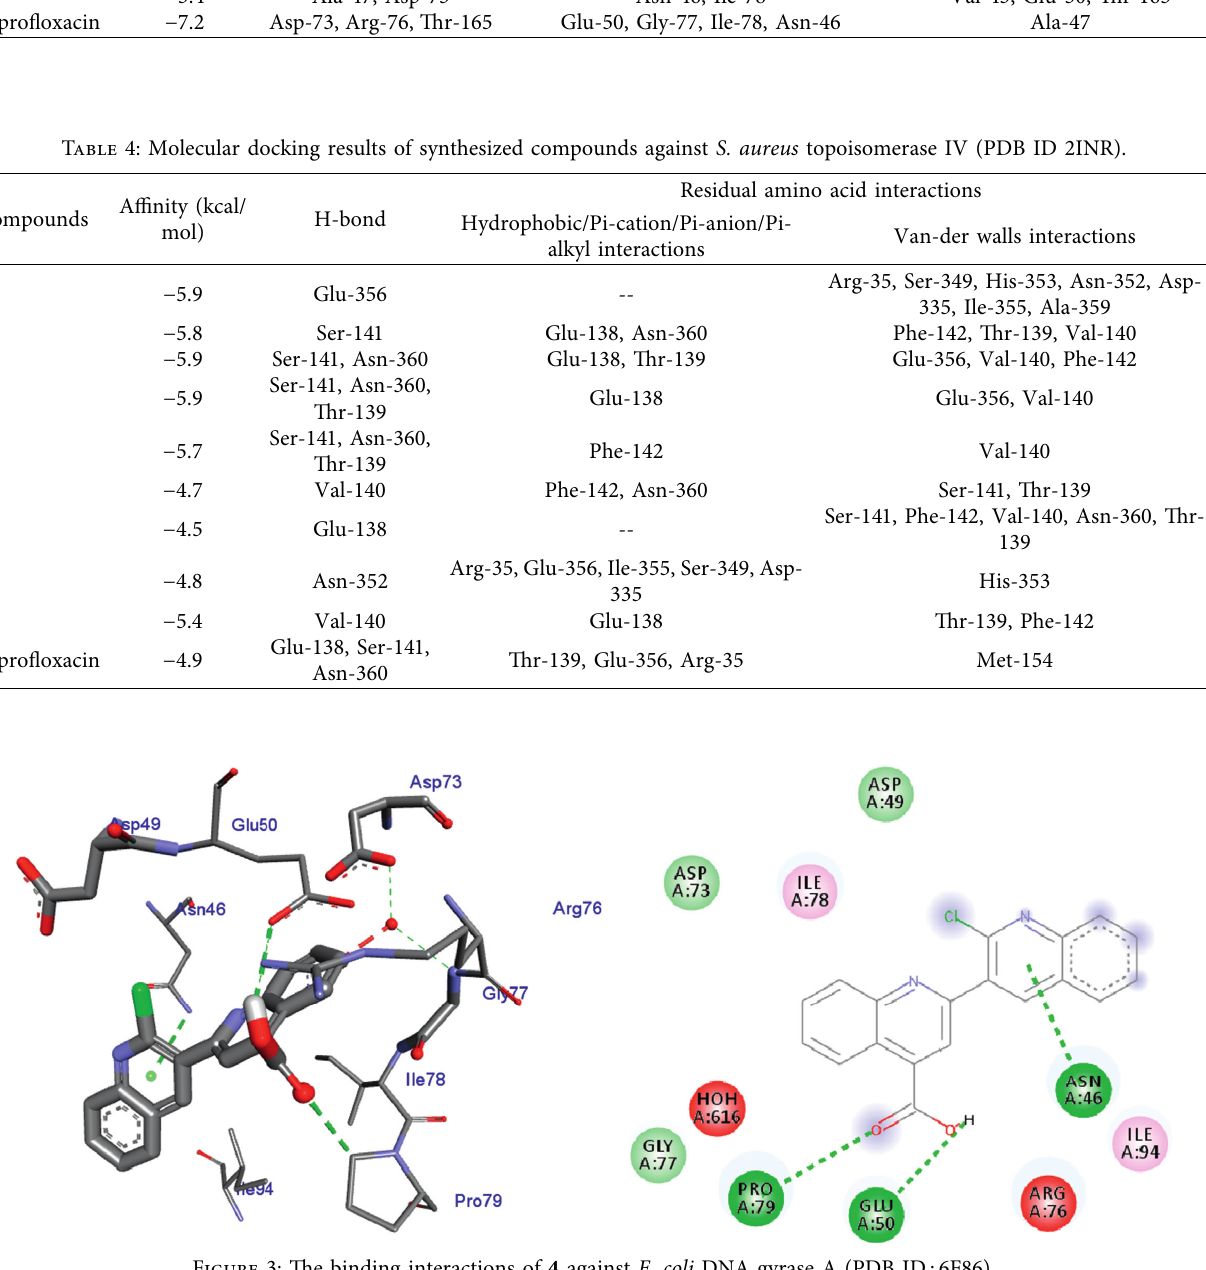
Figure 3: The binding interactions of 4 against E. coli DNA gyrase A (PDB ID